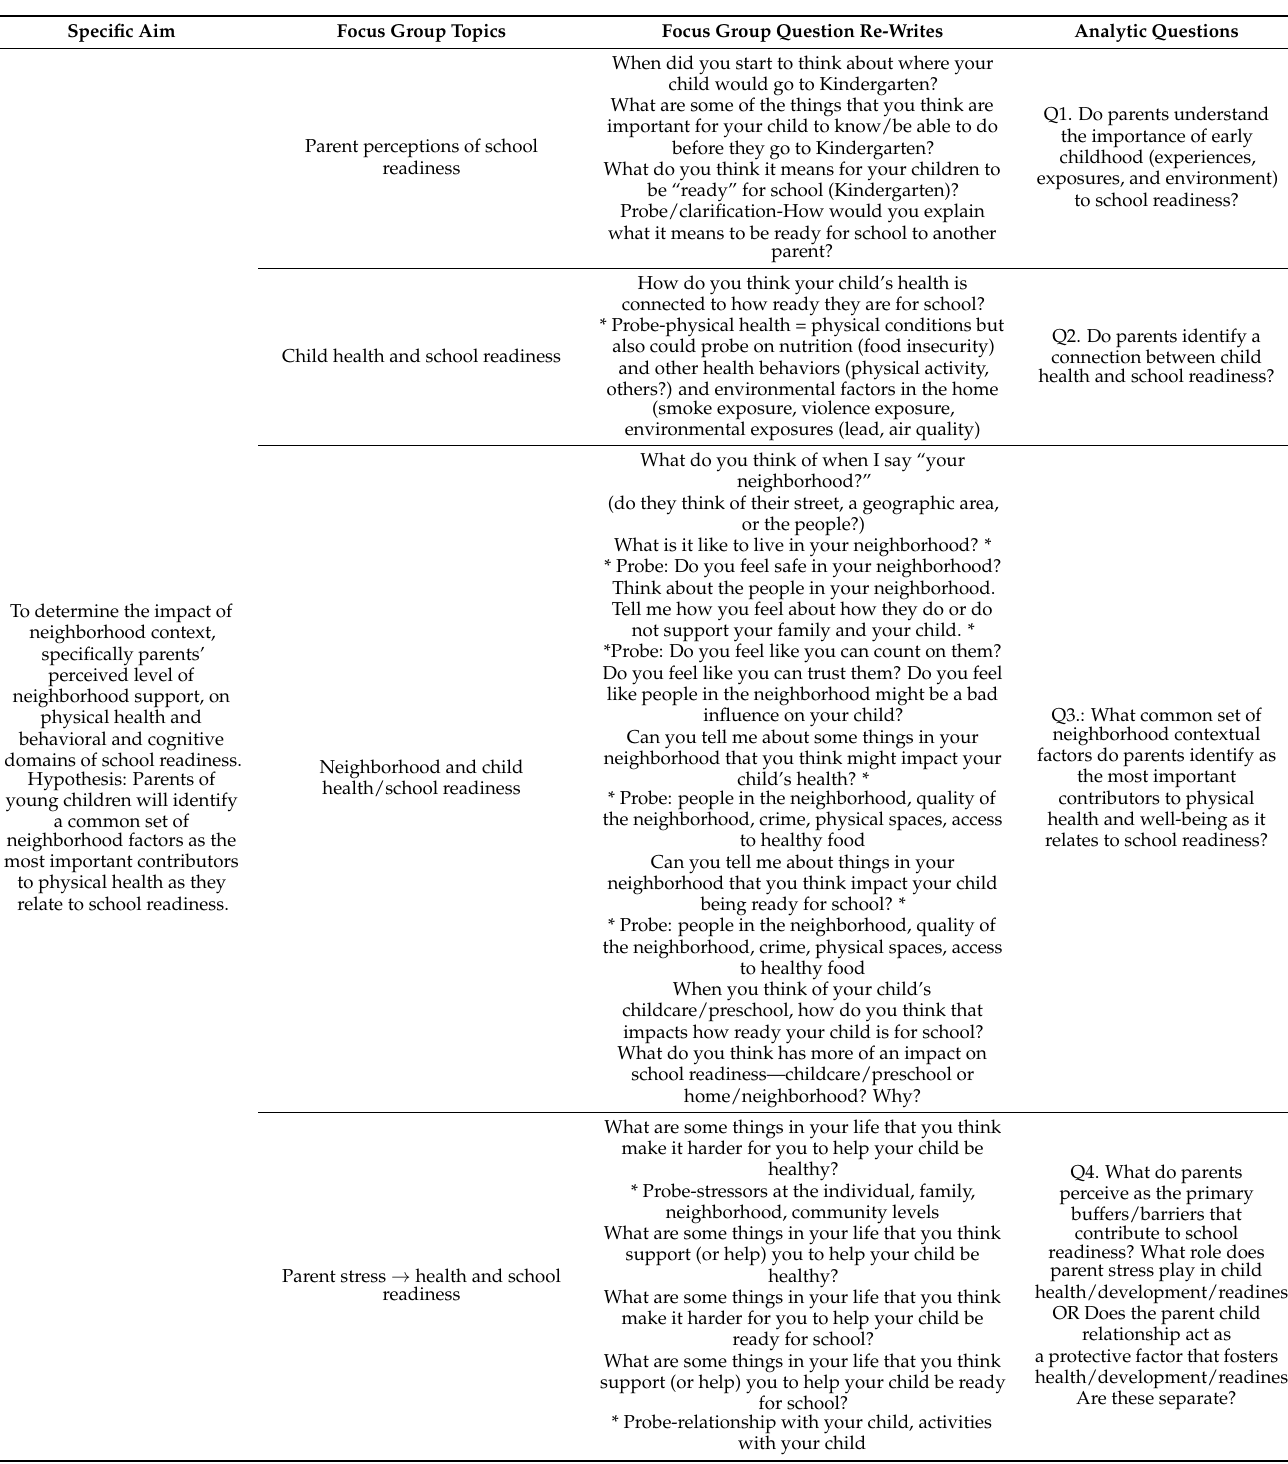
Table 1. Quantitative Analytic